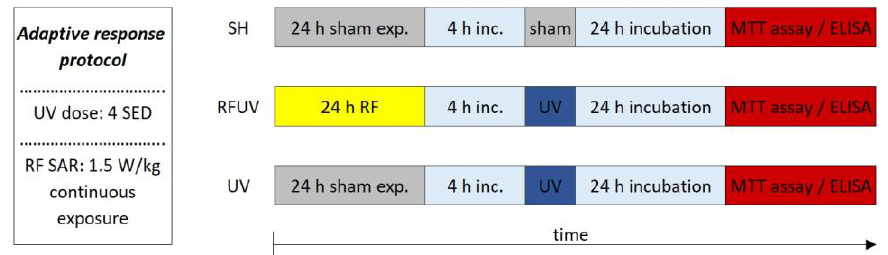
Figure 5. Timeline of the additive effect protocol where 2 SED UV irradiation was followed immediately by 24 h RF irradiation with 4 W/kg.